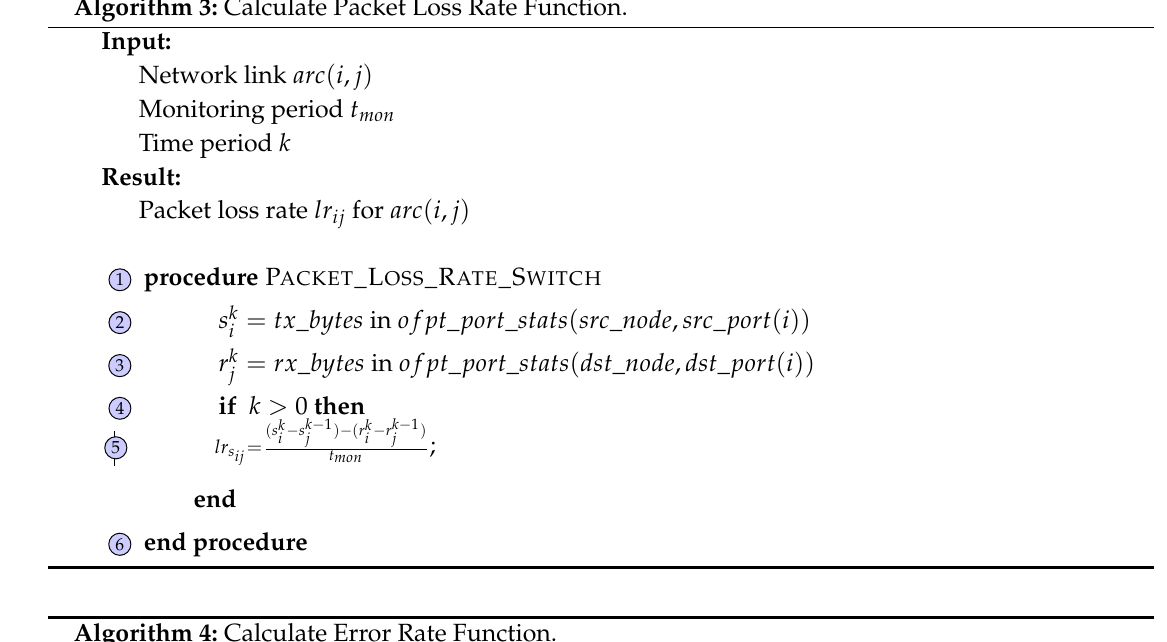
Algorithm 4: Calculate Error Rate